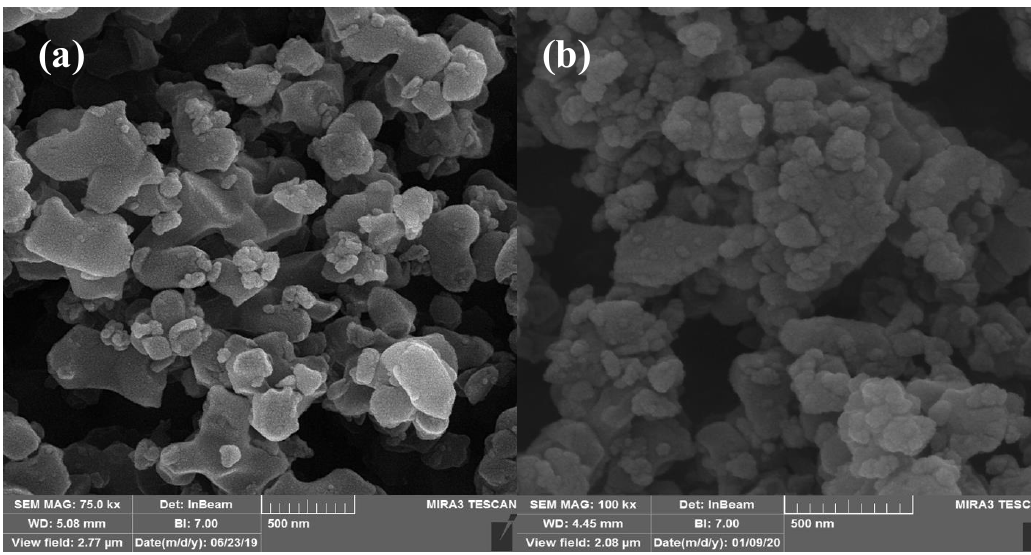
Fig. 7. FE-SEM images of the nanocatalysts (a) ZIF-8 and (b) Fe-ZIF-8.